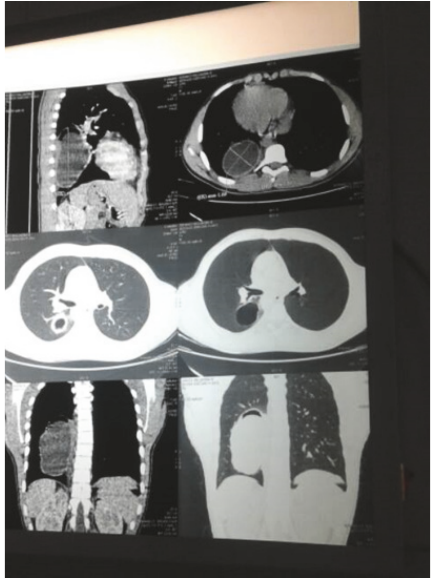
Figure3:ChestCTscanwithawell-circumscribedfluidattenuation lesion with homogenous content and smooth, hyperdense walls located in the lower lobe of the right lung measuring 30 by 20 by 27